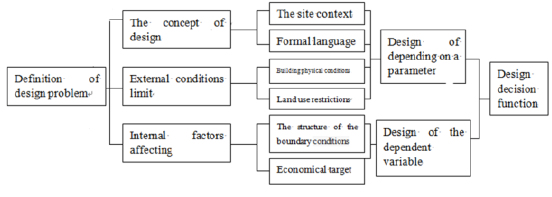
Figure 1: Definition of design problems